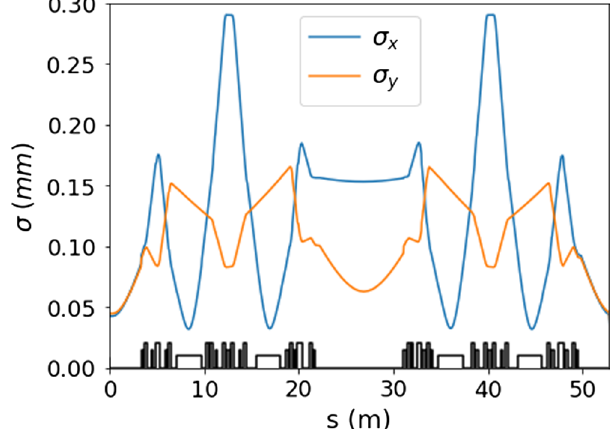
FIG. 8. On-resonance scheme: correlation between the quadru- pole roll errors and beam sizes at short straight centers when the ideal machine ’ s tune is on a difference resonance. The error bar is the standard deviation of 50 random seeds.